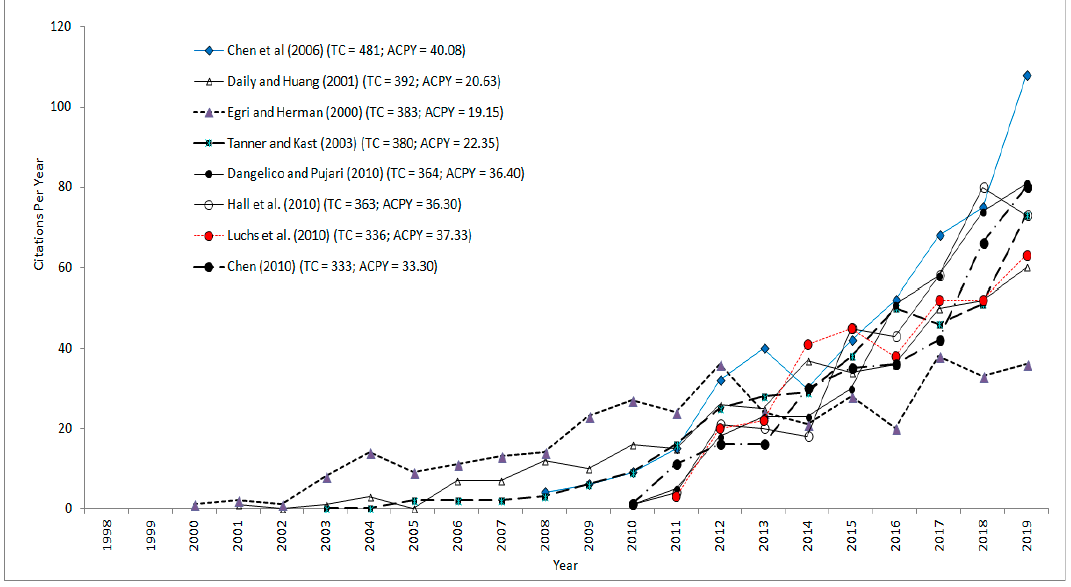
Figure 6. The citation life cycle of the highly cited articles in green products. (TC-Total Citations, ACPY-Average Citations per Year).